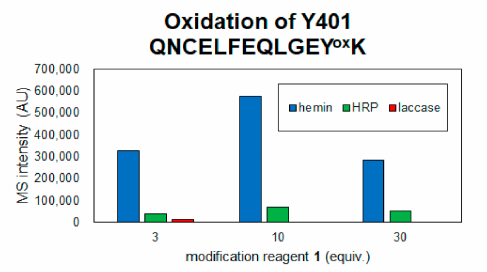
Figure 4. Detection of oxidized peptide of Y401 in each reaction